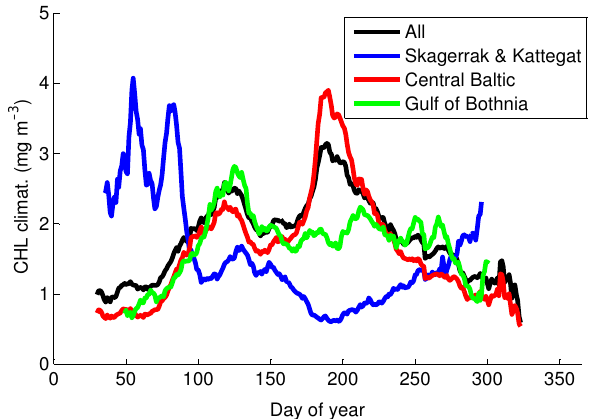
Figure 6. Chl a daily climatology. For any given day of the year, the average was computed only if data for a minimum of 6 years were available. Plots of individual time series with their associated standard deviation bars can be found in the Supplement. To improve the plot readability, all time series were smoothed with a 1-week moving